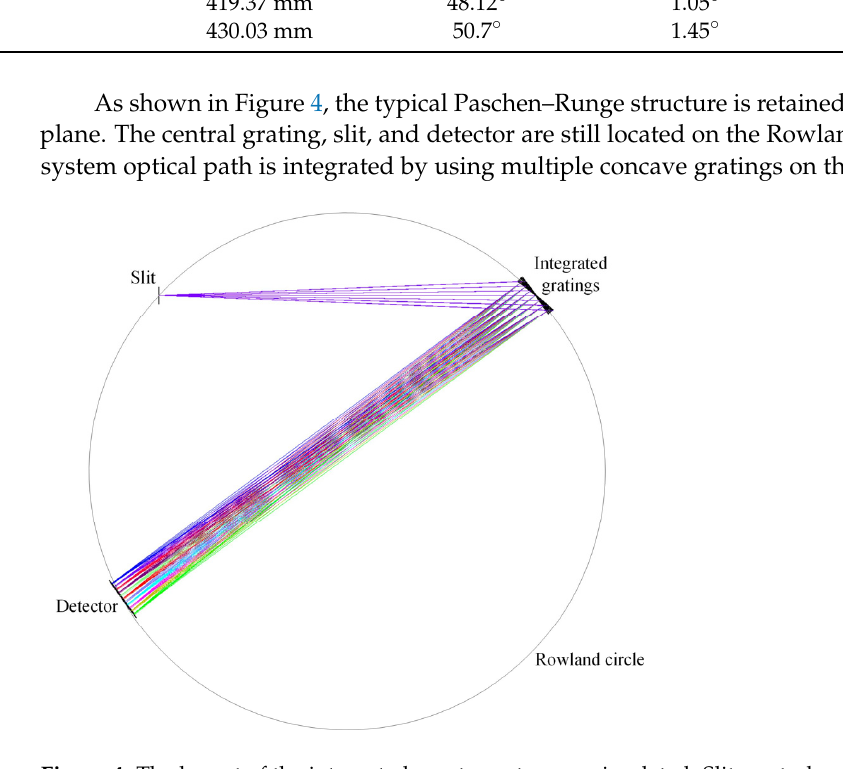
Figure 4. The layout of the integrated spectrometer was simulated. Slit, central grating, and detector on Rowland circle.